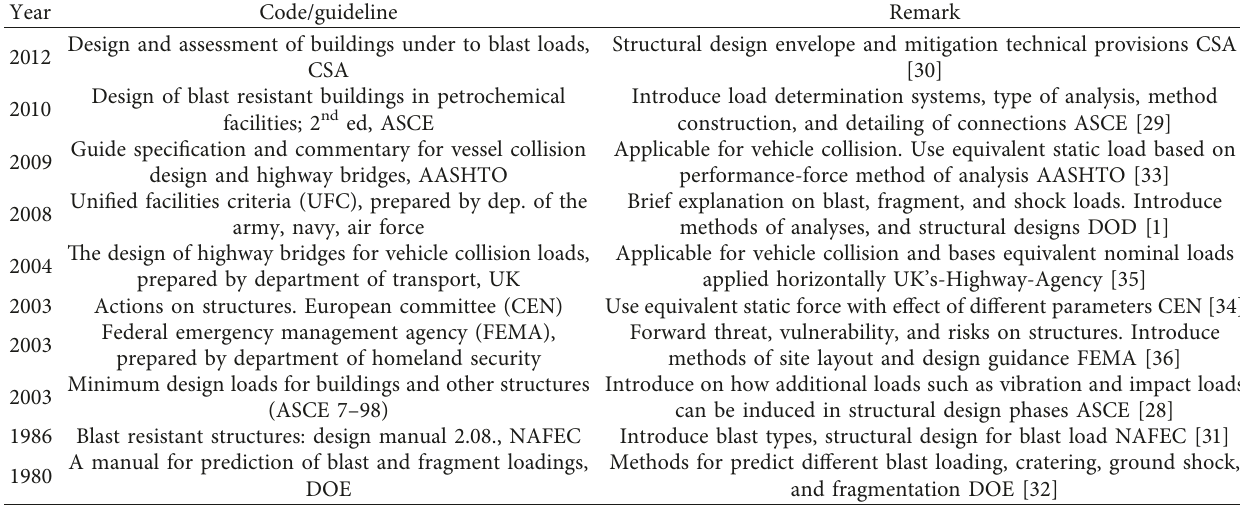
Table 1: Design code of practices for structures subjected to blast and impact